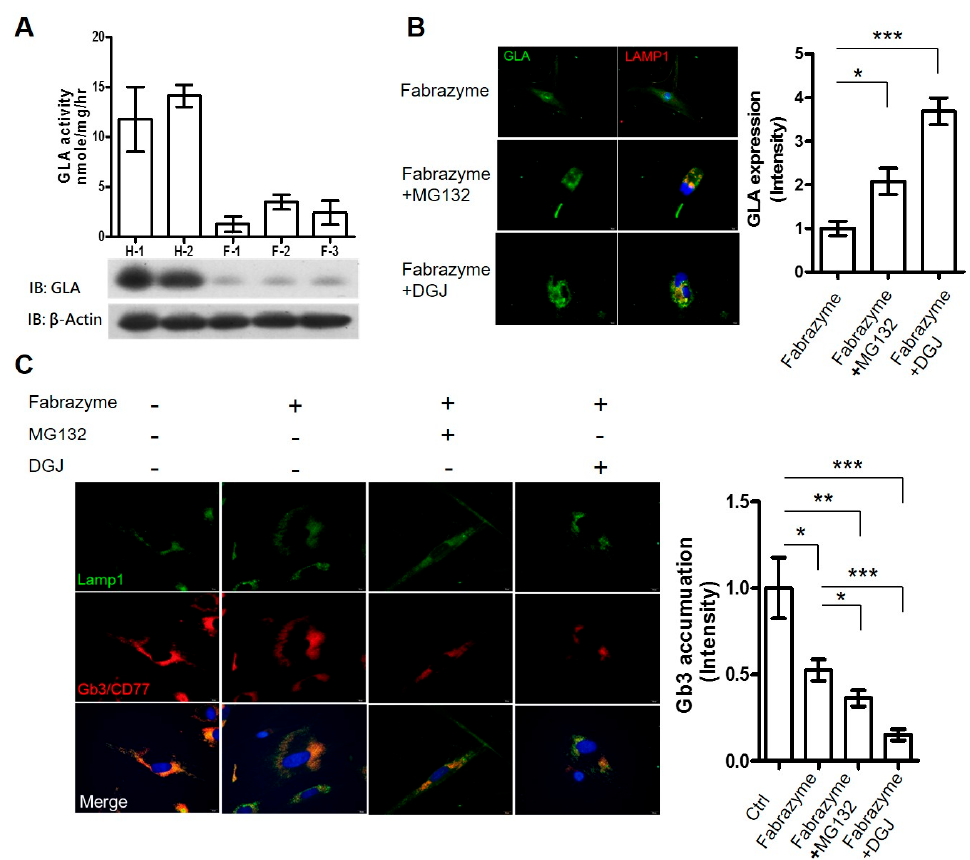
Figure 4. Subcellular localization of the rh α -GLA and the clearance of the lysosomal-accumulated Gb3 in Fabry patient-derived fibroblasts co-treated with Replagal and MG132. ( A ) The protein expressions and enzyme activities of GLA were characterized in the fibroblasts that derived from healthy subjects (H-1 and H-2), and the FD patient carrying GLA IVS4 + 919G>A mutation (F-1, F-2, and F-3); ( B ) Subcellular localization of the Fabrazyme rh α -GLA was determined by immunofluorescence staining in the FD patient fibroblast co-treatment of 0.1 µM Fabrazyme with 1 µM MG132 or 100 µM DGJ. The rh α -GLA was probed with anti-GLA antibody and then labeled with FITC (green). The lysosome marker LAMP1 was probed with rabbit anti-LAMP1 antibody and then labeled with TRITC (red). Cell nuclei were labeled with DAPI (blue). A representative immunofluorescence analysis from three independent experiments is shown. The quantitative results are presented as mean ± SEM ( n ≥ 10 cells). * p < 0.05 and *** p < 0.001 vs. Fabrazyme treatment only. Scale bar equals 20 µm; ( C ) Lysosomal-accumulated Gb3 was determined by immunofluorescence staining. The FD patient-derived fibroblasts were grown on coverslips and co-treated with 0.1 µM Fabrazyme—1 µM MG132 or 100 µM DGJ for 24 h—and then replaced in fresh medium for another 10 days. Subsequently, the Gb3 was probed with rat anti-Gb3/CD77 antibody and then labeled with TRITC (red). The lysosome marker LAMP1 was probed with rabbit anti-LAMP1 antibody and then labeled with FITC (green). Cell nuclei were labeled with DAPI (blue). The color yellow in the merge indicated the lysosomal-accumulated Gb3. Representative immunofluorescence data are presented, and the quantitative results are presented as mean ± SEM ( n ≥ 10). * p < 0.05, ** p < 0.01, and *** p < 0.001 vs. the non-treatment (Ctrl) or Fabrazyme treatment only. ”+” and “-“ represented the cell treatment with and without Fabrazyme/MG132/DGJ administration, respectively. Scale bar equals 20 µm.